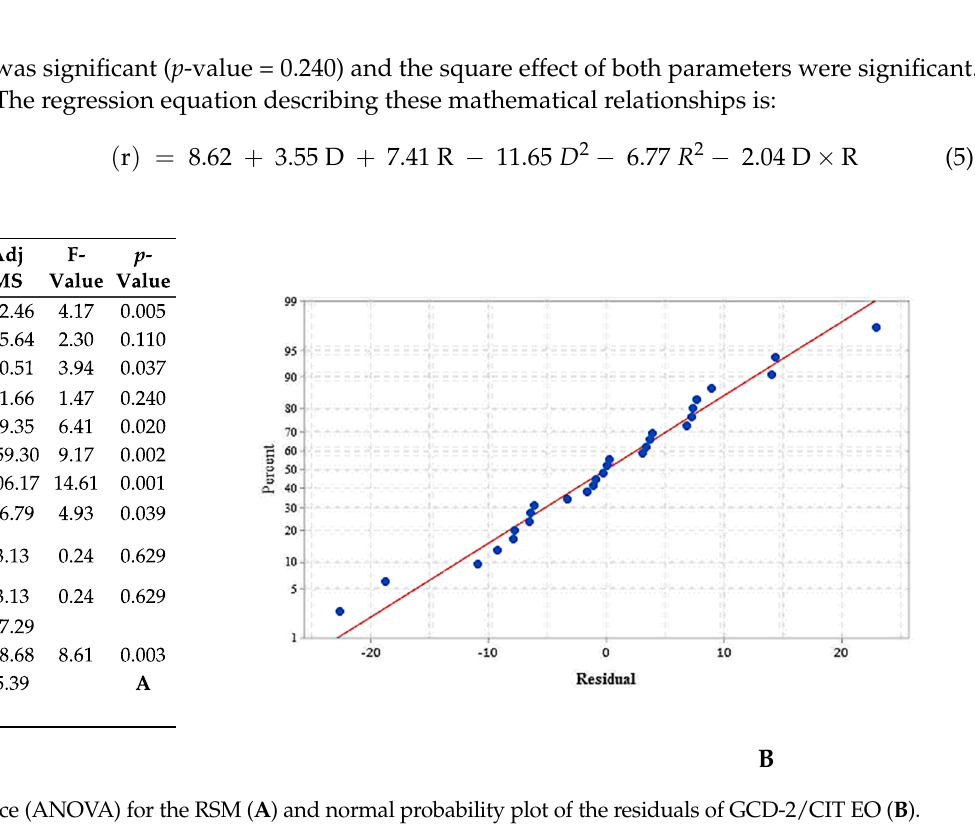
12 of 16 Figure 9. Contour plots showing the crossed effect of duration (D) and rate of stirring (R) on the retention rate (r) of cinnamon essential oil by GAD-1. 3.3.4. GCD-2/CIT